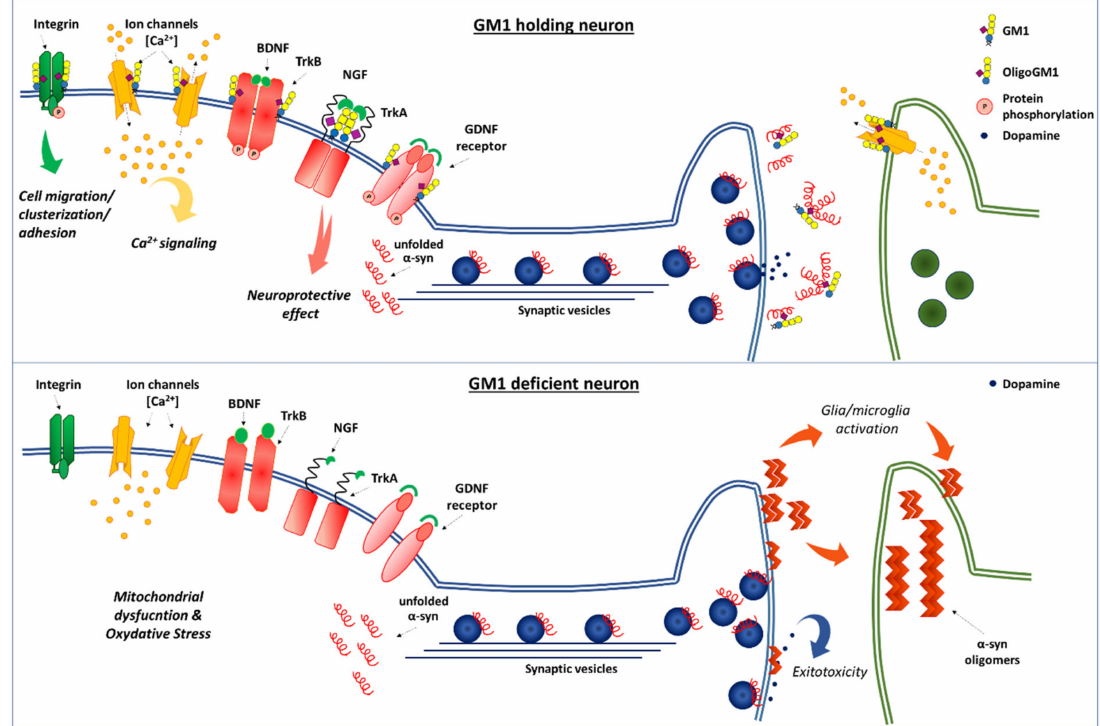
Figure 5. Neuronal function dependent by interaction between the GM1 oligosaccharide and proteins [106]. On the top of the image there is a healthy neuron holding with correct GM1 level that sustains neuron homeostasis and also the clearance of α -synuclein. Some of the fundamental neuronal processes that require the association between GM1 oligosaccharide and protein at the plasma membrane level are represented. The viability of dopaminergic neurons depends particularly on the neurotrophic and neuroprotective signaling throughout Trk(s) and RET receptors [2,9]. Fundamental for neuronal survival is also the GM1 collaboration with ion channels (calcium) and integrin receptors [9]. Finally, it is shown also the α -synuclein association with synaptic vesicles and its release in presynaptic region functioning as a regulator of dopamine neurotransmission [197–200]. Here the correct level of plasma membrane GM1 maintains, in out hypothesis, the α -synuclein in the non-aggregating forms. On the bottom, a neuron with GM1 deficiency and hence a deficiency of its oligosaccharide, that leads to the loss of all the important neurotrophic signals and to α -synuclein aggregation and accumulation. GM1 sugar code is according to Varki et al.